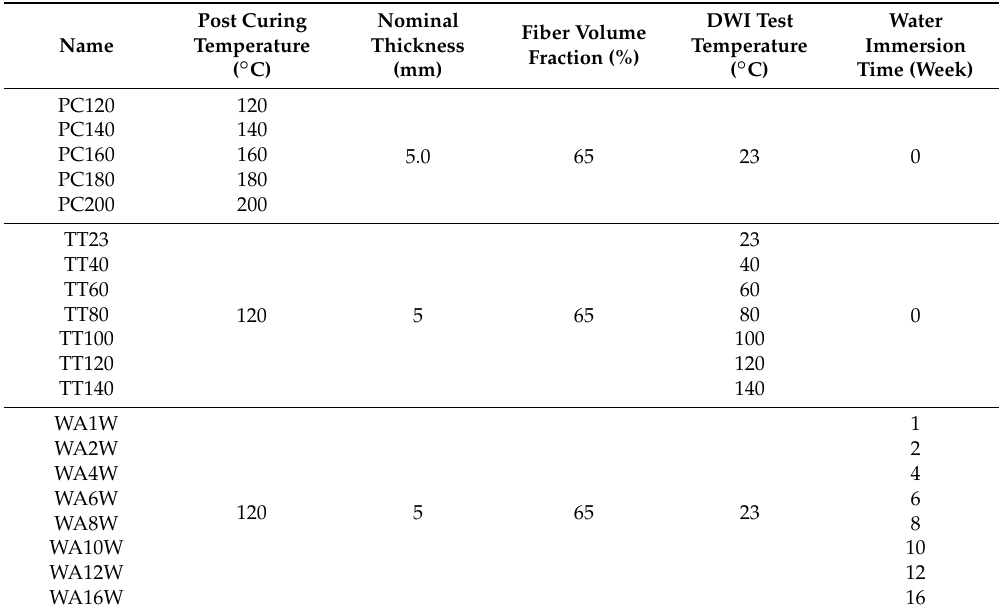
Table 1. Summary of flax fiber reinforced composite samples for the drop weight impact (DWI)